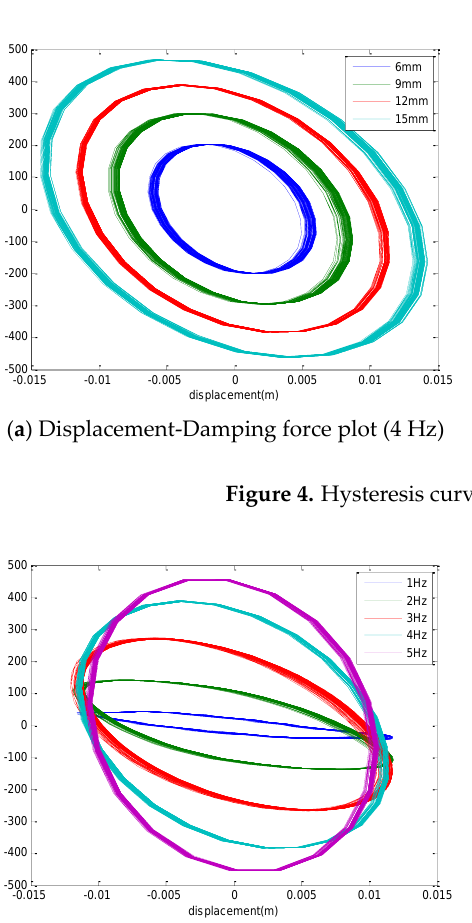
Figure 4. Hysteresis curve (4 Hz, various amplitude).